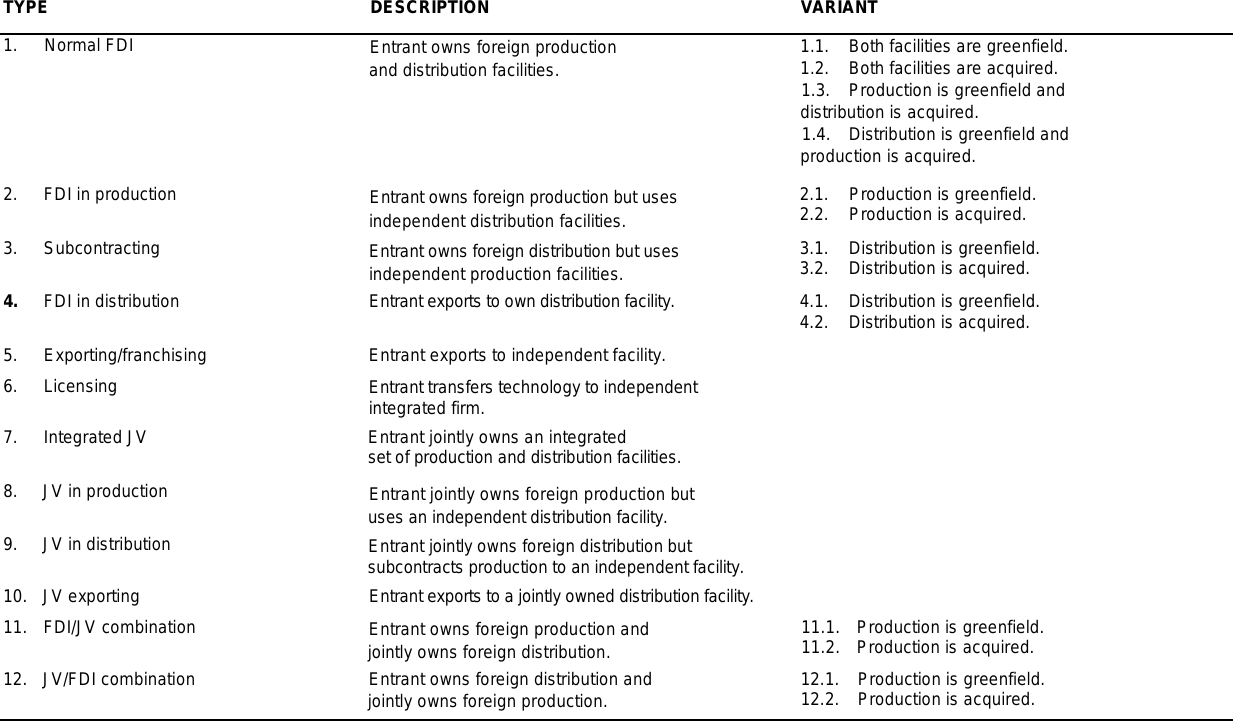
Table 3. Twelve Entry Modes and Their Variants Source [22]